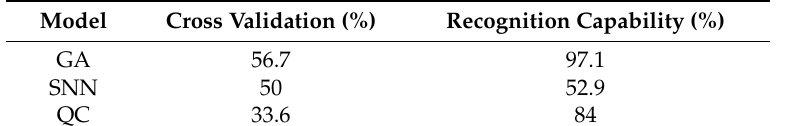
Table 2. Three different algorithms: genetic algorithm (GA), supervised neural network (SNN), and quick classifier (QC) were used to distinguish between the peptide composition of the group of women diagnosed with GTN after GTN treatment and the non-pregnant control group.